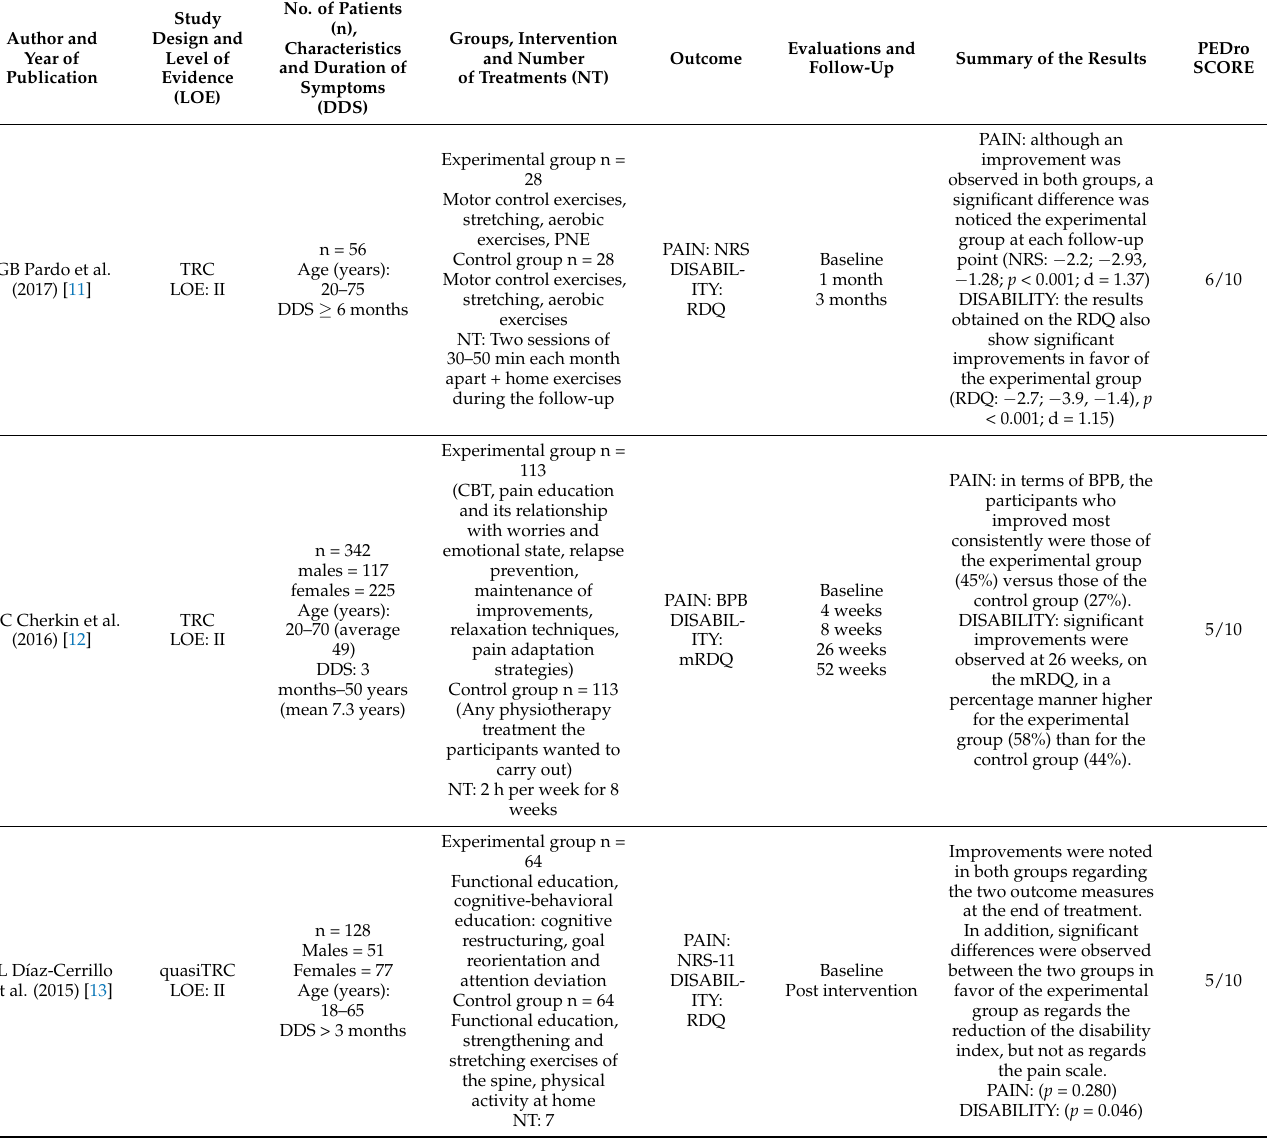
Table 5. Summary of the articles